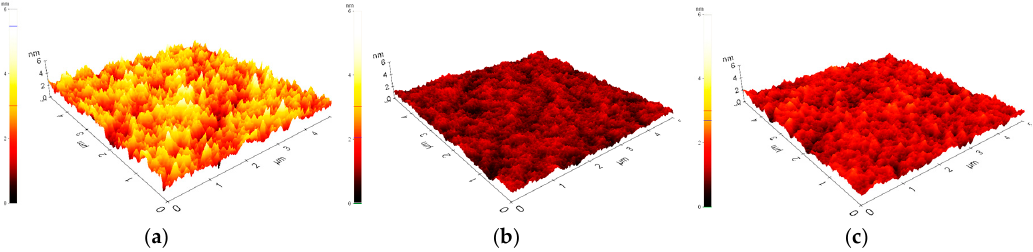
Figure 3. 5 × 5 μ m AFM images of ITO/PEDOT:PSS ( a ); ITO/PEDOT:PSS/ SimCP3 ( b ); and ITO/PEDOT:PSS/ SimCP3 :FIrpic (10 wt %) ( c ).